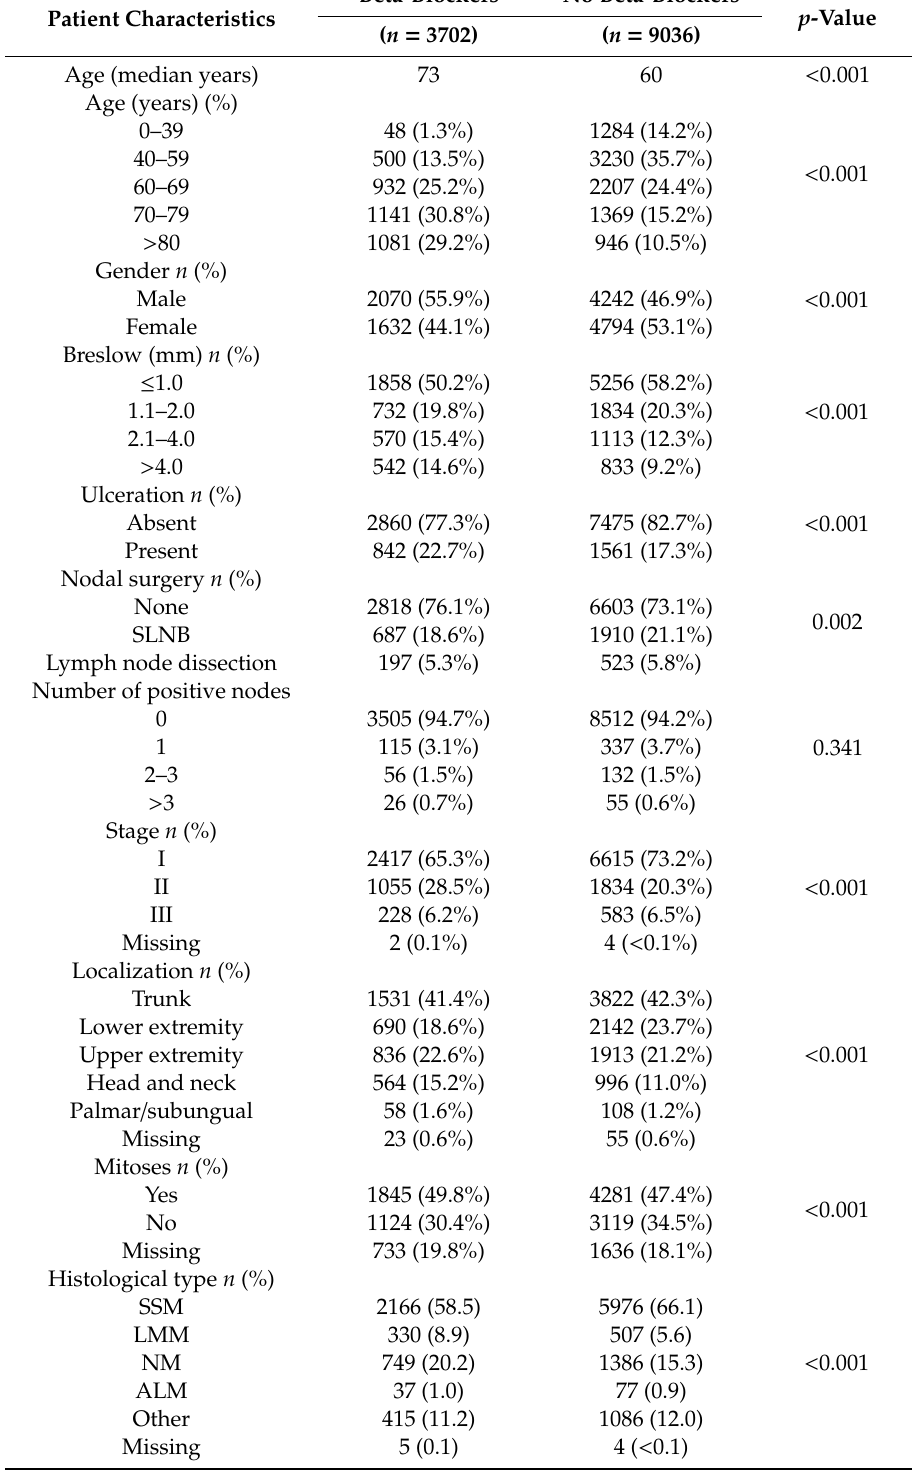
Table 1. Patient and tumor characteristics in patients with primary stage I–III cutaneous melanoma diagnosed between 2009–2013 in